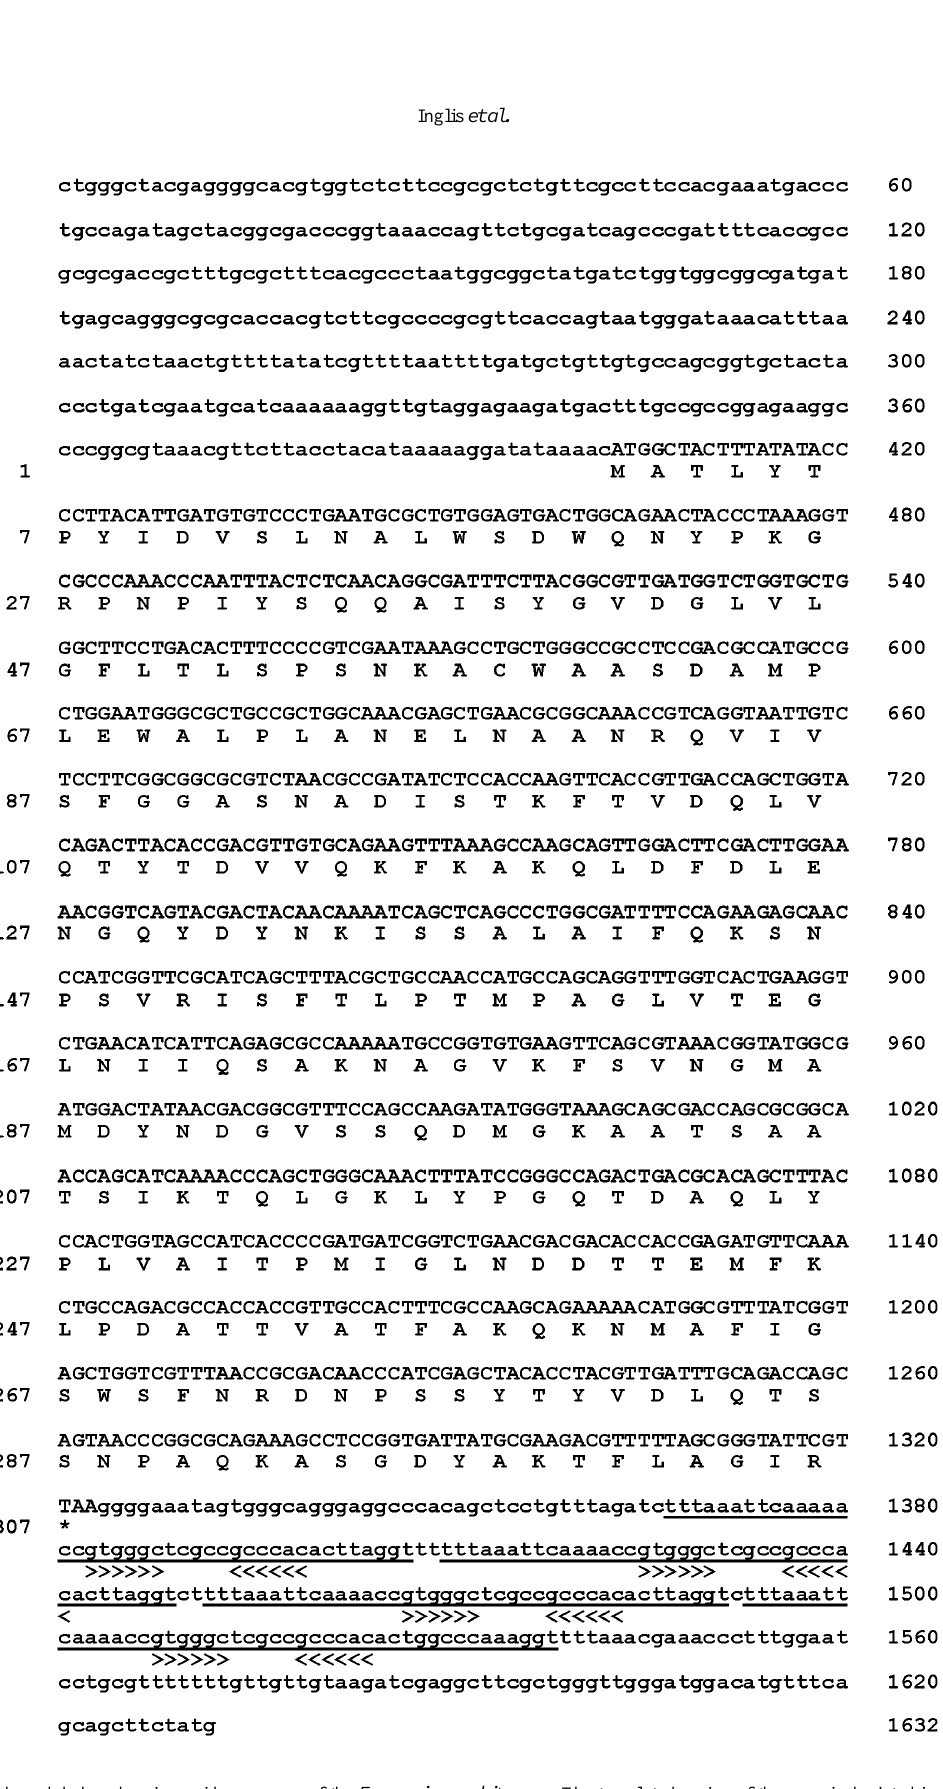
Figure 1 - Nucleotide and deduced amino-acid sequences of the E. americana chi A gene. The translated region of the gene is depicted in upper case letters. Four direct repeats downstream of the TAA stop codon (marked with an asterisk) are underlined and a palindromic sequence within the direct repeats is indicated by chevrons. This sequence is deposited in EMBL/Genbank/DDBJ with accession number